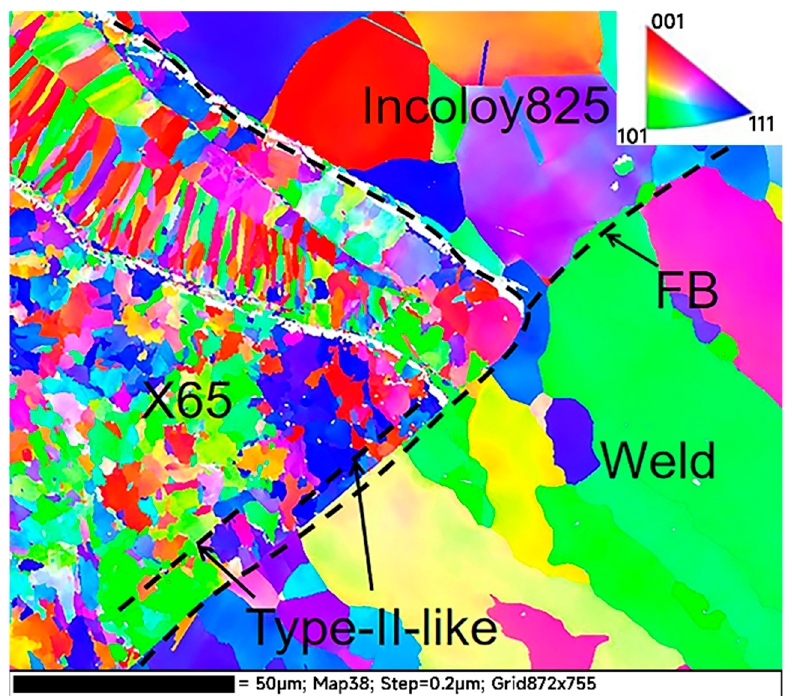
Figure 5. The IPF diagram of the intersection of three zones.